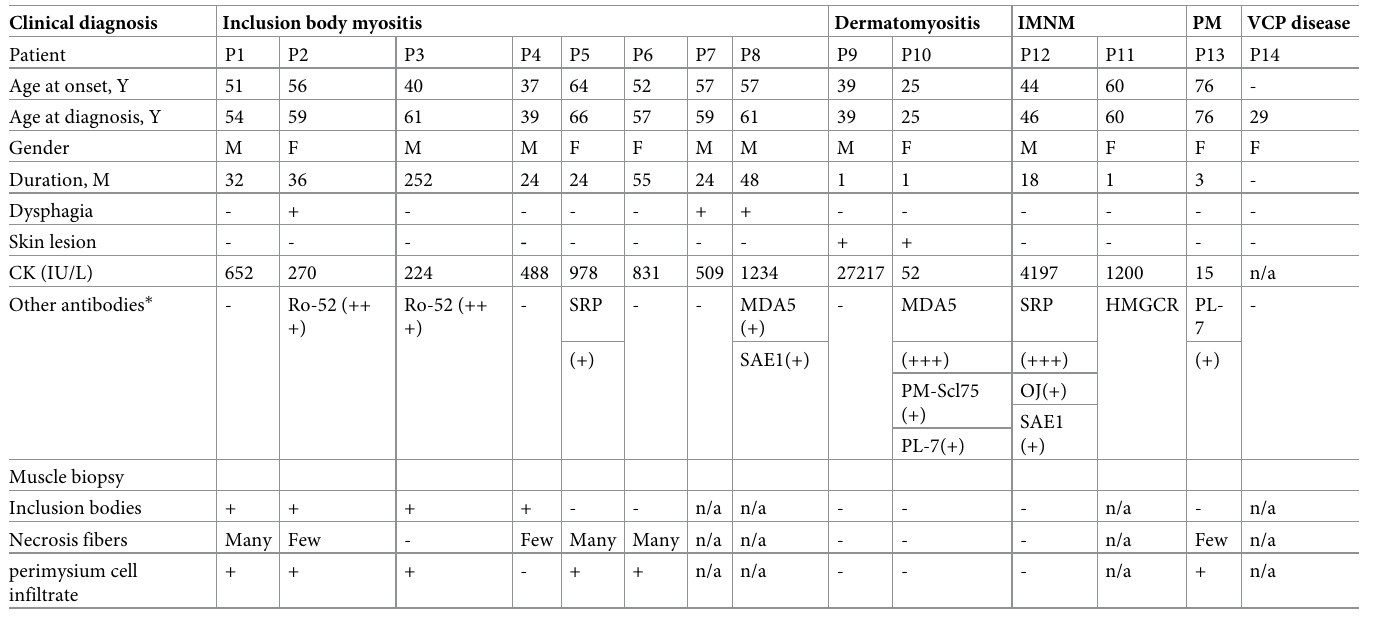
Table 2. Clinicopathologic presentation and laboratory parameters of patients with anti-NT5C1A antibody (n = 14). Clinical